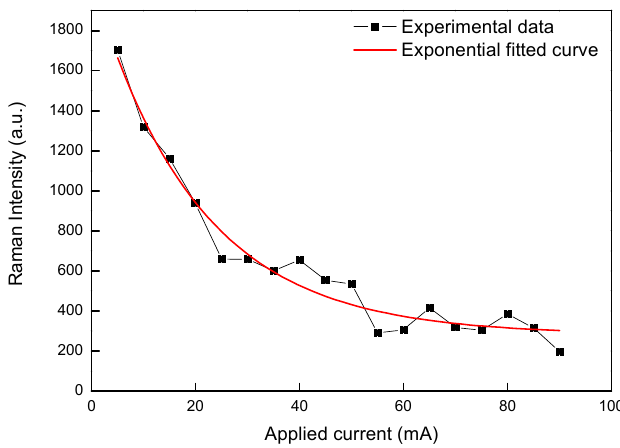
Figure 11. Measured Raman intensity as a function of electric current applied on the micro-heater.